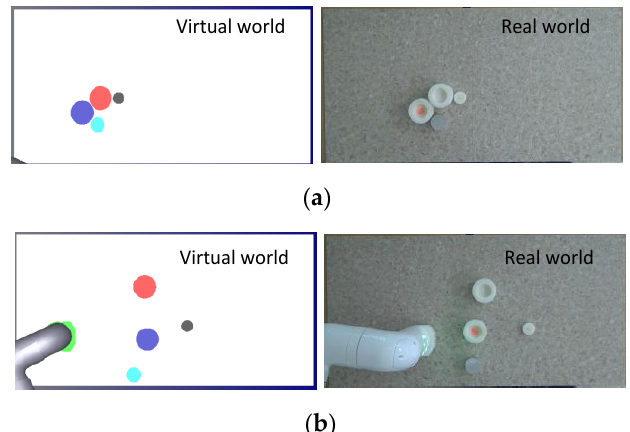
( a ) ( b ) Figure 16. Scattering experiments for singulation of four objects by considering general shapes: ( a ) before collision; ( b ) after collision. Manipulator velocity: 0.5 m/s. 6. Quantitative Analysis In this section, the real and virtual world results are compared to evaluate how exactly the physical properties are estimated. We measured the distance among all objects after singulation in the virtual world and real world. The quantitative data is shown in Figure 17. Figure 17a–c denote the comparison of real/virtual world’s distance for the case of two objects and three objects singulation, respectively. Similarly, the distance comparison of real/virtual world for the case of four objects is shown in Figure 17d,e. There is a small error, which is expected because we are using the average value of estimated parameters, and ground truth of the friction coefficient varies even on one surface [13]. The error is comparatively grater for the case of general shape objects. This is because, for circular shaped objects, the contact direction is always toward the center. It is confirmed that the distance between any two objects is greater than 𝑑 min = 90 mm and that the condition given in Equation (35) is also satisfied in all cases. Conclusively, the proposed scattering algorithm was found to be effective to analyze and control the scattering behavior of objects being singulated by collision with a robot manipulator. The attached video clips demonstrate the whole procedure of training the physical properties of objects and scattering experiments.